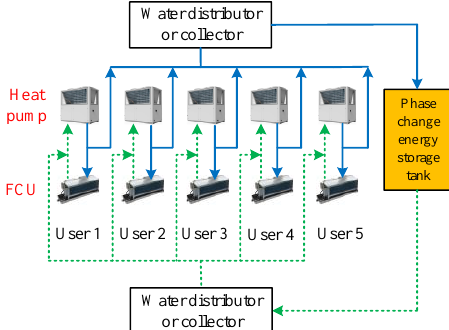
Figure 8. Theoretical framework of the control